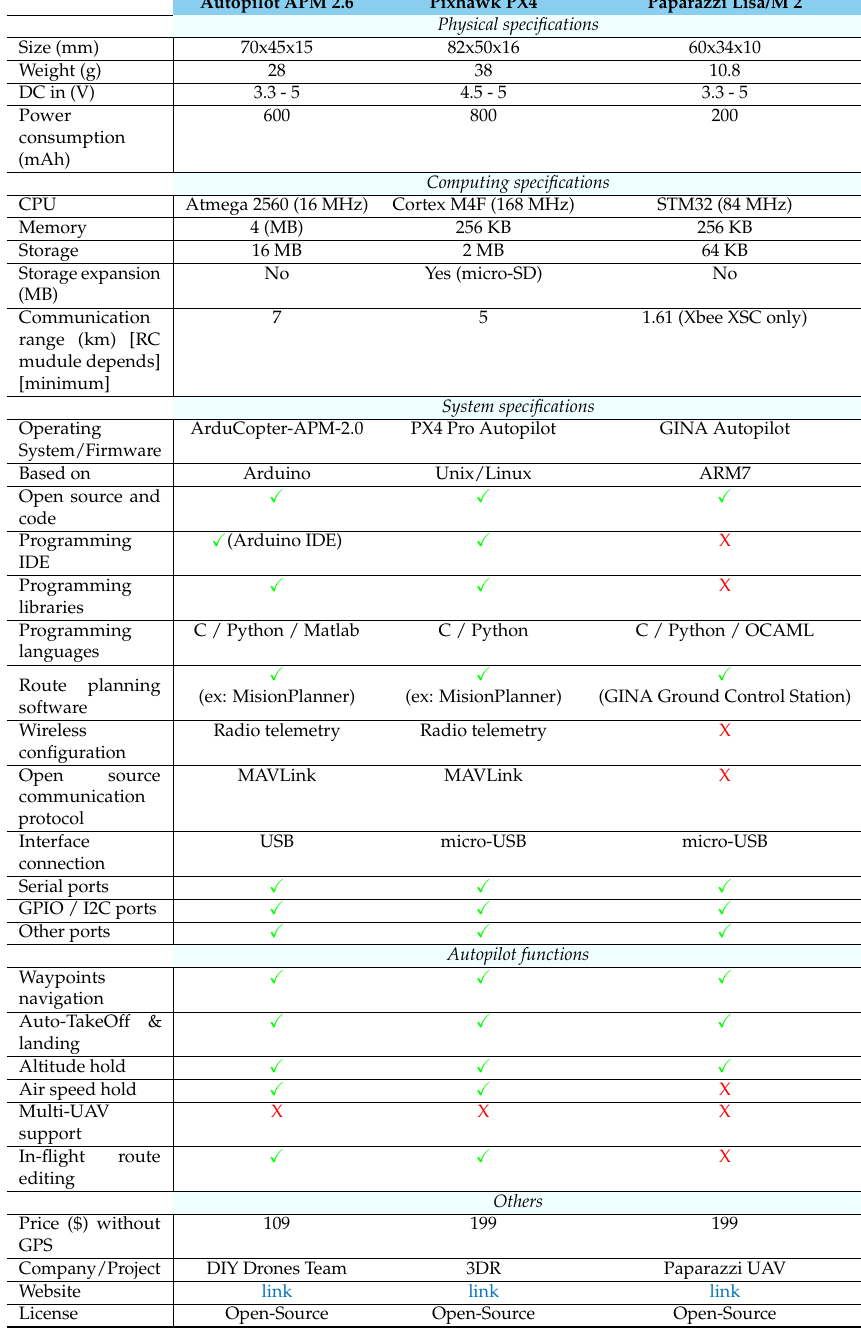
Table 7. Autopilot